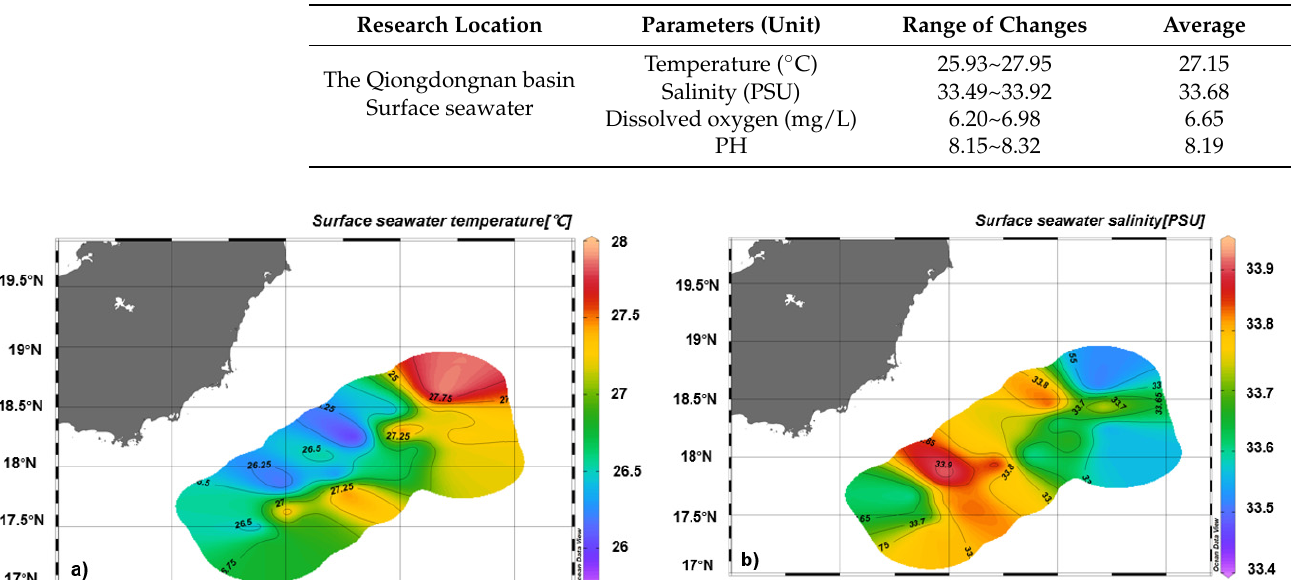
Table 2. The hydrological and chemical data of the Qiongdongnan basin.